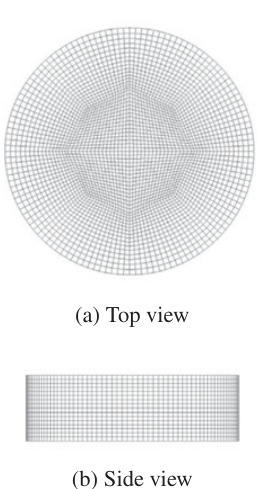
Fig. 13. Compressive test specimen after compression (Simula- tion); 550 [1 / s] of Fig. 7.